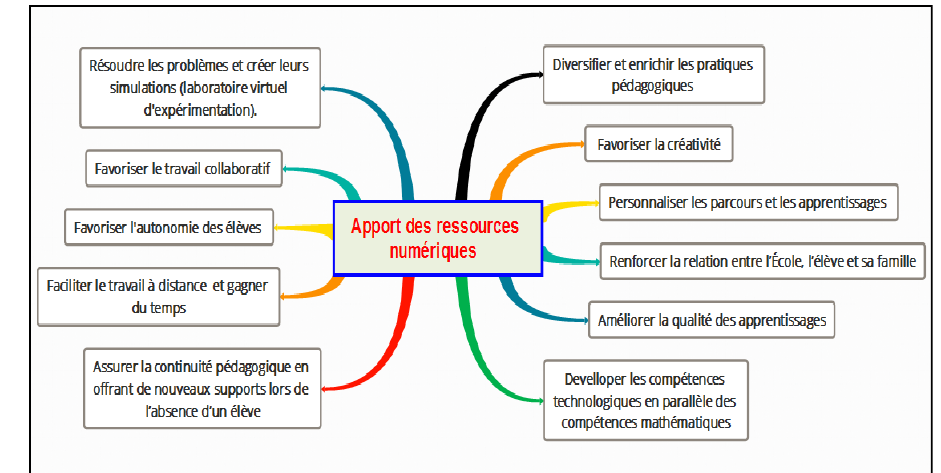
Fig. 2. Apport des ressources